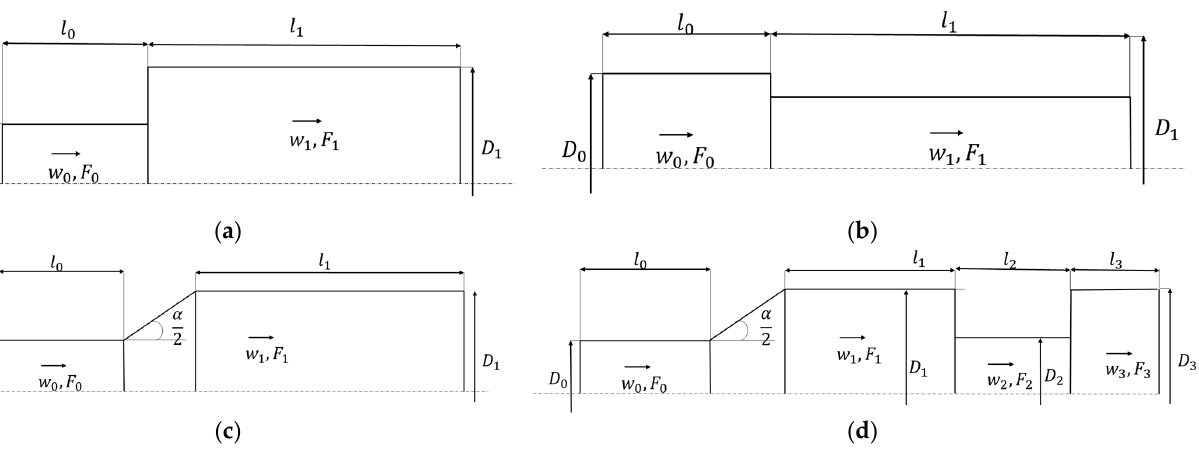
Figure 2. Sketches of the considered geometries: ( a )—channel with a sudden expansion; ( b )—channel with a sudden contraction; ( c )—diffuser channel; ( d )—compound channel. Table 1. Geometrical and operating characteristics of the studied channels. С hannel with a Sudden Expansion